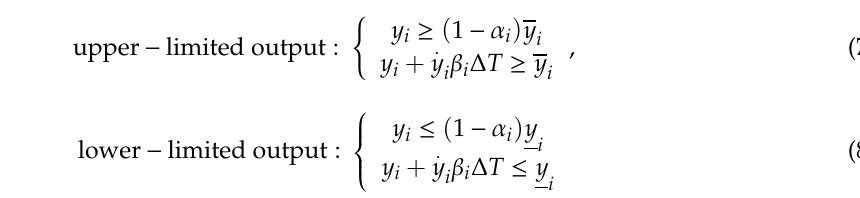
( d ) Figure 5. Aero-engine response curves using direct switching method based on output-based switching logic: ( a ) High-pressure rotor corrected speed response; ( b ) High-pressure compressor outlet total pressure response; ( c ) Mixing chamber inlet total temperature response; ( d ) Controller index. It can be seen that the multi-loop control method based on the non-linear output-based switching logic will lead to excessive overshoot and oscillation, which will seriously affect the control performance of the engine, although the high-pressure rotor speed finally tracks its reference. The reason for the problems above is that the difference of the engine control input signals